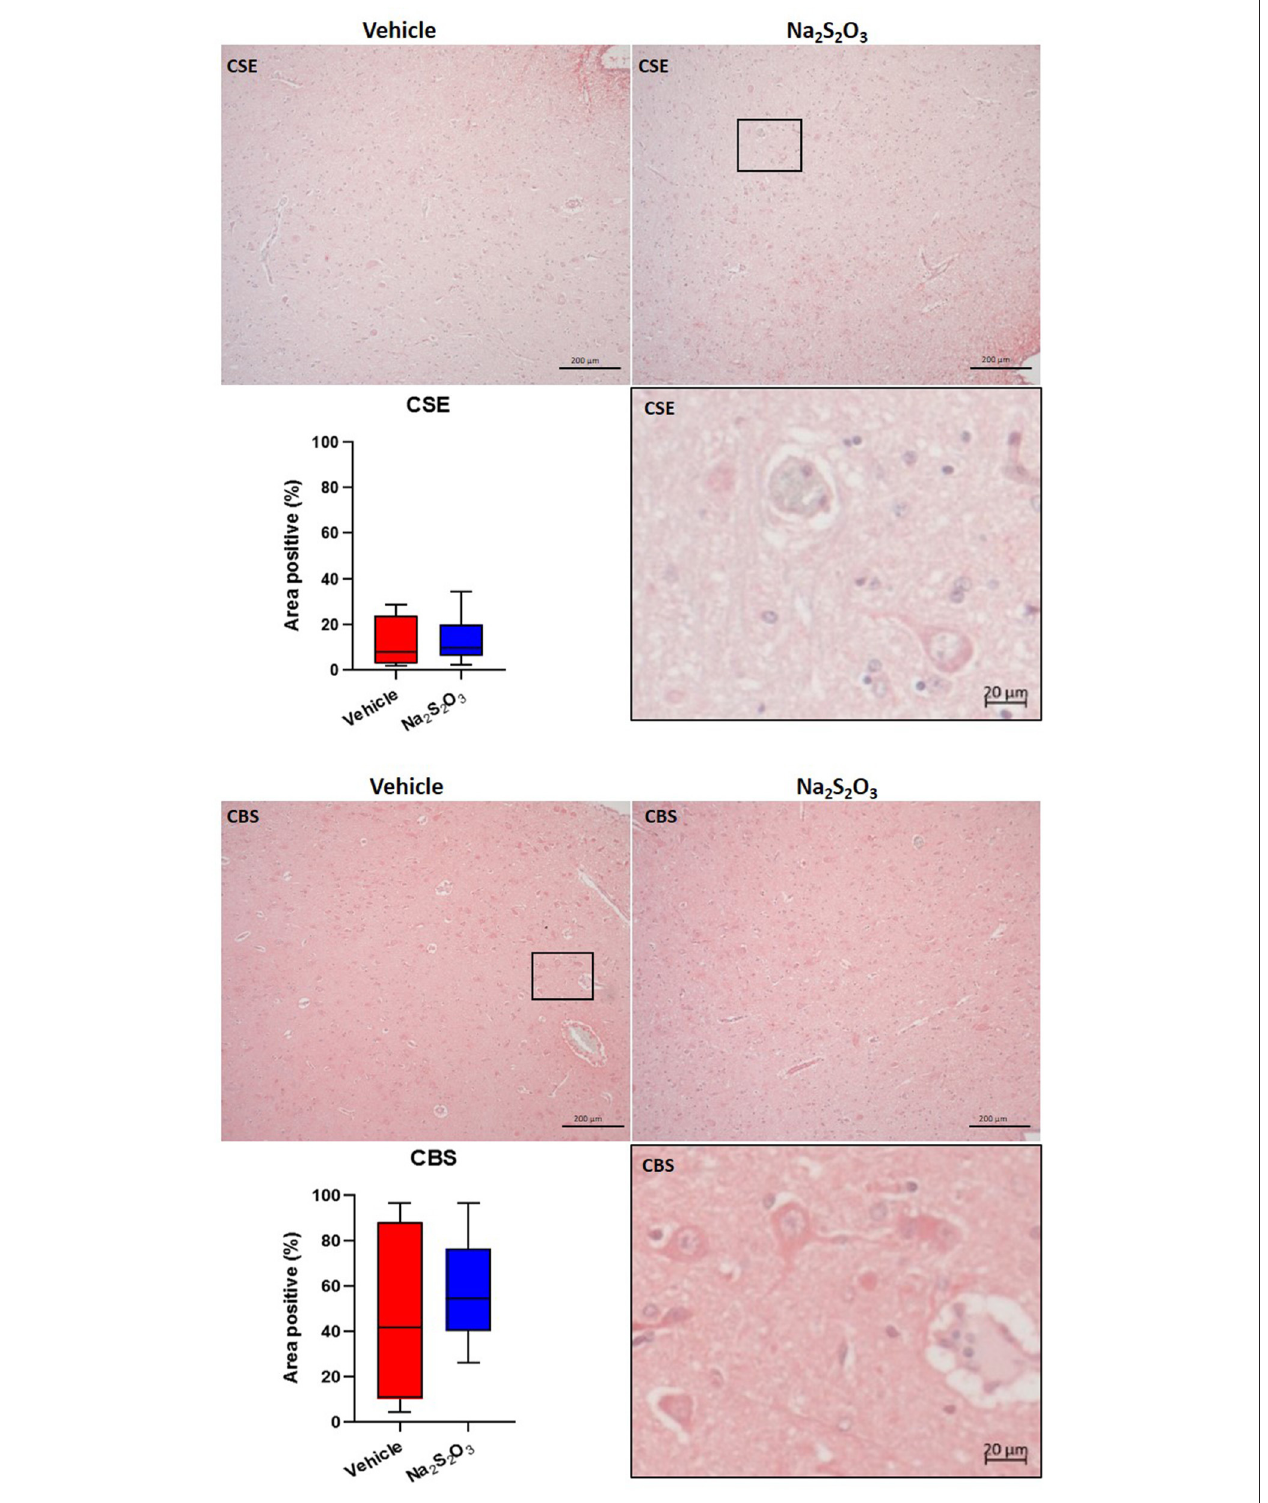
FIGURE 2 | H 2 S producing enzymes in the porcine PVN. Quantification of the immunohistochemical stainings as positive percentage area in the PVN for CSE (vehicle: n = 4; Na 2 S 2 O 3 : n = 6) and CBS (vehicle: n = 5; Na 2 S 2 O 3 : n = 7). Boxes represent the interquartile ranges with the median (black line), whiskers represent minimum and maximum values. Exemplary immunohistochemical pictures of CSE and CBS in the PVN of vehicle and Na 2 S 2 O 3 treated animals (10X). Higher